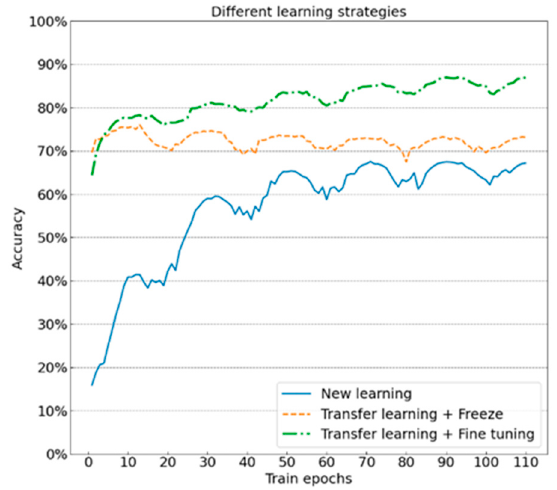
Figure 9. Accuracy of models with different learning strategies.